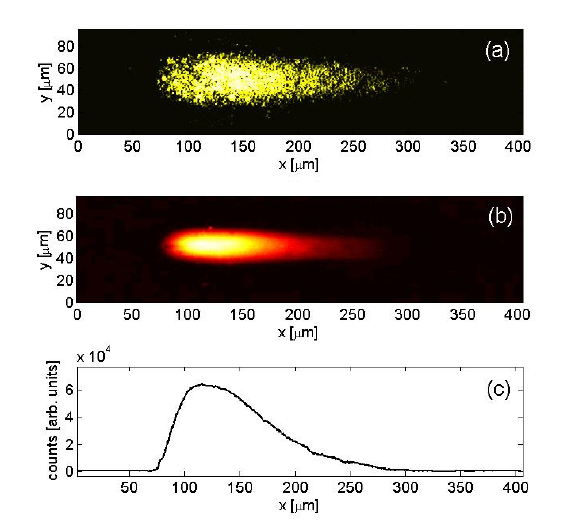
Figure 5. BSW spatial distribution imaged by collecting ( a ) the light scattered by microdefects on the 1D photonic crystal surface, and ( b ) the fluorescence emitted by organic dyes on the 1D photonic crystal surface; ( c ) Fluorescence intensity profile along the BSW propagation direction. Reprinted from I.V. Soboleva, E. Descrovi, C. Summonte, A.A. Fedyanin, F. Giorgis, Appl. Phys. Lett. 94, 231122 (2009) with the permission of AIP Publishing